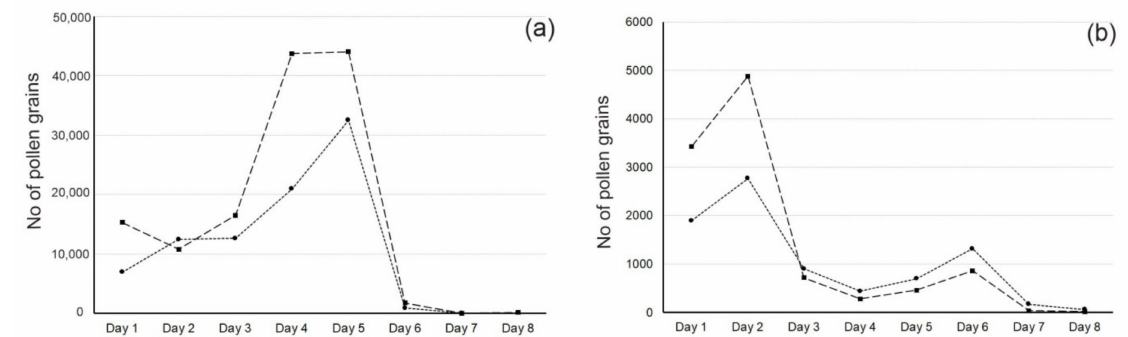
Figure 2. Fluctuations of the number of pollen grains in subsequent days of anthesis depending on the variant of the experiment and year of study; ( a ): first year, ( b ): second year of the study. In both graphs: dashed line—spatial isolation, dotted line - border